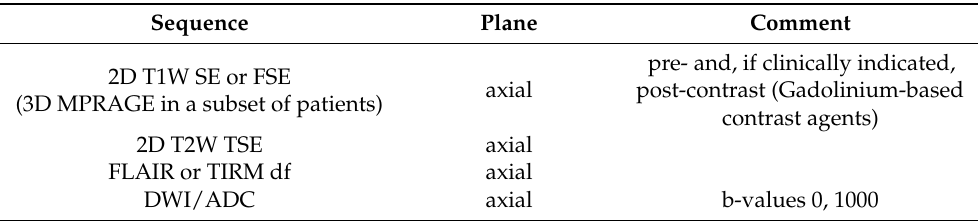
Table 1. Group of basic MRI sequences available for review. T1W = T1-weighted; T2W = T2-weighted; SE = spin echo; FSE = fast spin echo; TSE = turbo spin echo; TIRM = turbo inversion recovery magnitude; df = dark fluid; FLAIR = fluid-attenuated inversion recovery; DWI = diffusion-weighted imaging; ADC = apparent diffusion coefficient. Sequence Plane Comment pre- and, if clinically indicated, 2D T1W SE or FSE axial post-contrast (Gadolinium-based (3D MPRAGE in a subset of patients) contrast agents) 2D T2W TSE axial FLAIR or TIRM df axial DWI/ADC axial b-values 0,